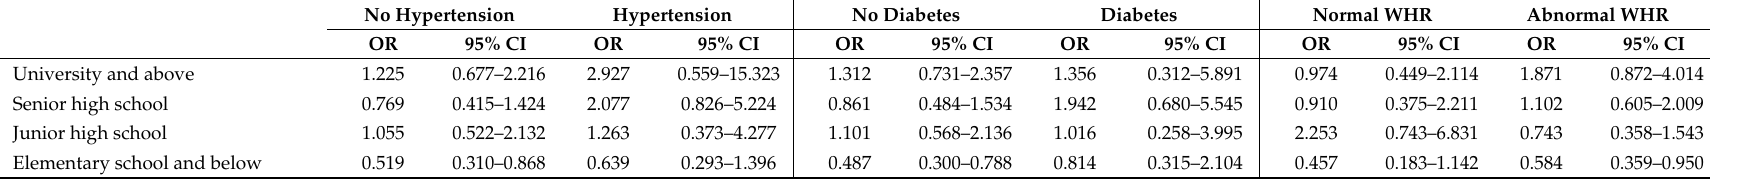
Table 6. E ff ect of sex on MMSE scores with respect to educational level and risk